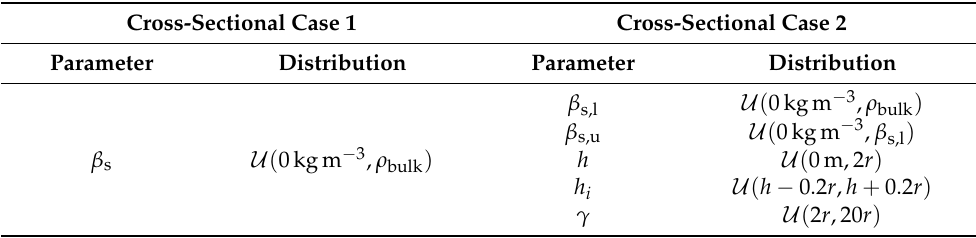
Table 2. Parameters and their respective distributions for the Monte Carlo simulation for uncertainty quantification for both cross-sectional cases of the flow